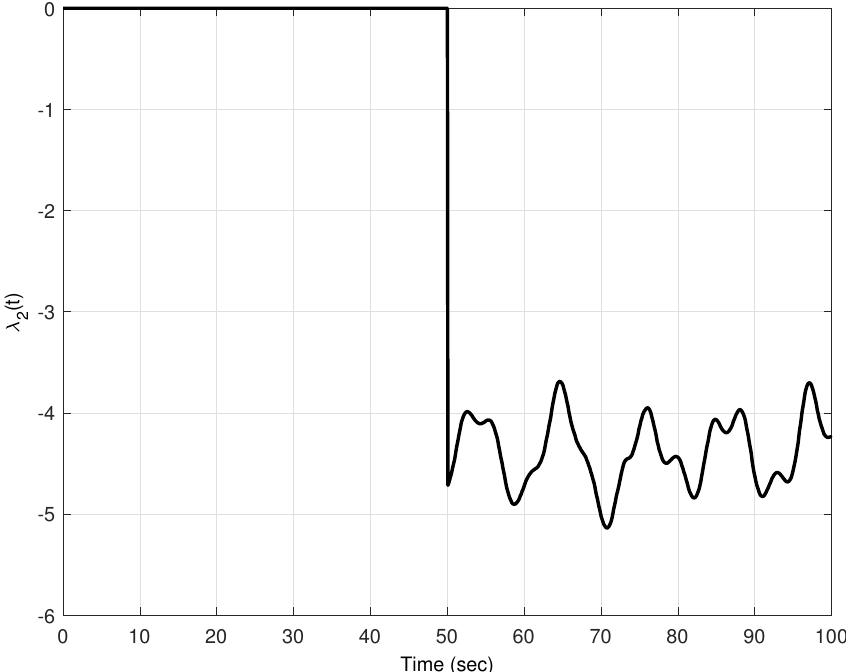
Figure 6. Time evolution of the second largest eigenvalue λ 2 ( t ) using chaotic